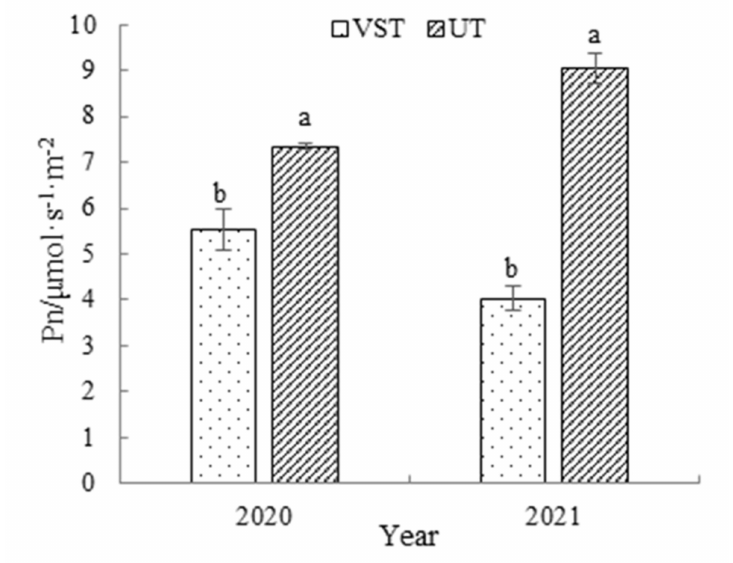
Figure 7. Effects of canopy types on the net leaf photosynthetic rate. Values are the mean of three replicates and error bars denote the SD. Different lowercase letters indicate significant differences based on Duncan’s multiple range test ( p <